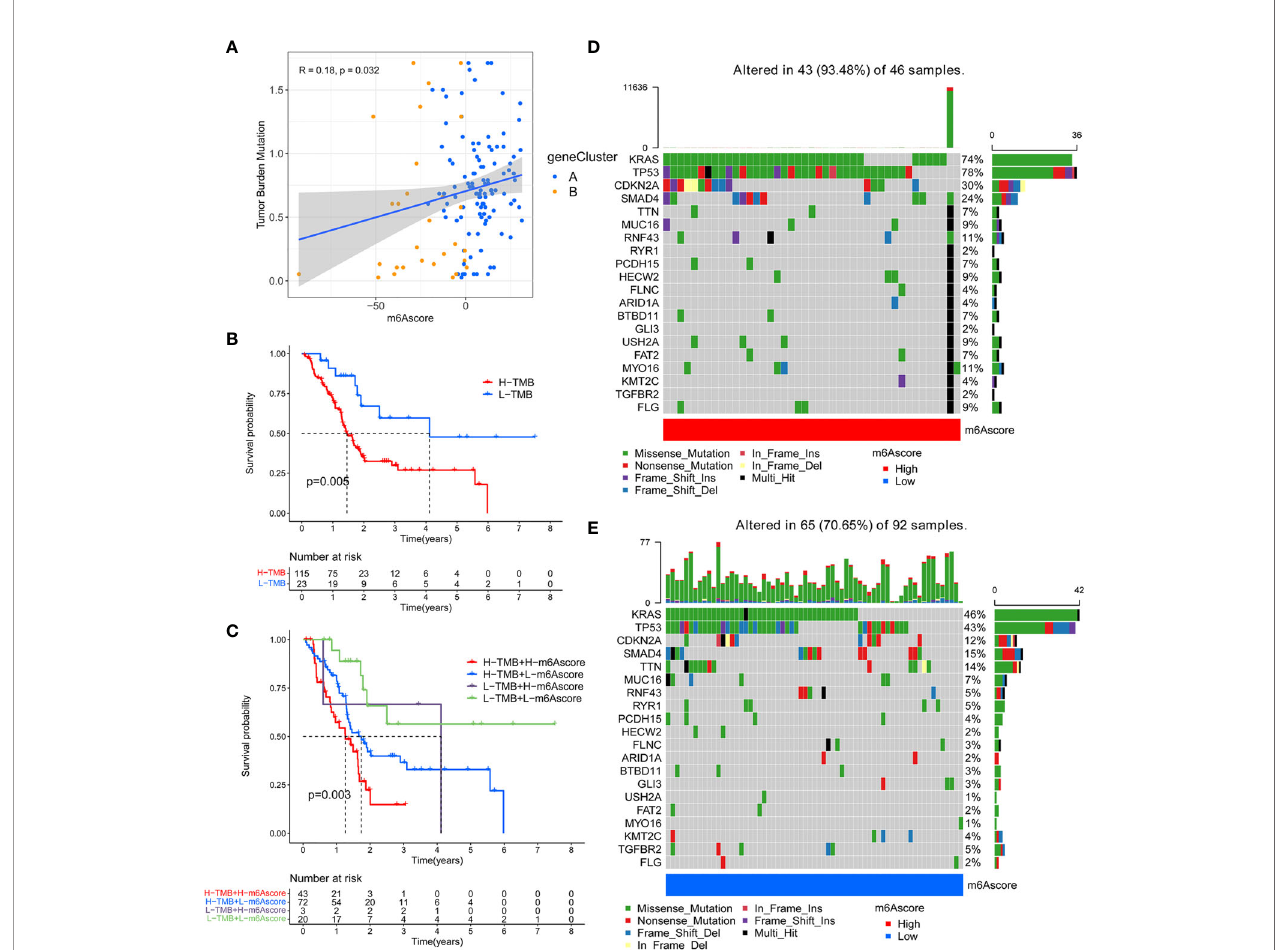
FIGURE 6 | Correlation between m 6 A score and tumor mutation burden (TMB) in TCGA-PAAD cohort. (A) A scatter plot describing the positive correlation between m 6 A score and tumor mutation burden. (B) Survival analysis of high TMB group and low TMB group. (C) Strati fi ed survival analysis including TMB and m 6 A scores. (D) OncoPrint for gene mutations in the high m 6 A score group. (E) OncoPrint for gene mutations in the low m 6 A score